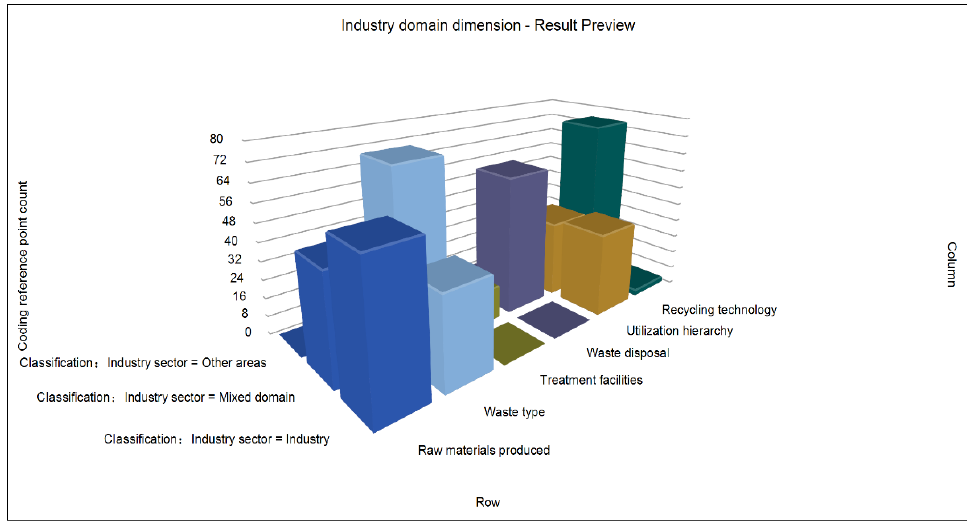
Figure 4. Counting diagram of matrix coding reference points under industry domain dimension.